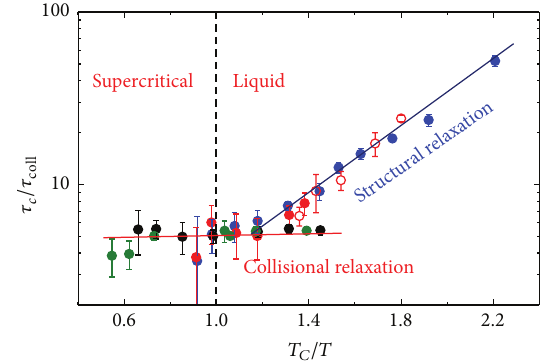
Figure 19: The same data as in Figure 18 are here rescaled for the corresponding collisional relaxation time (see (11)). The straight lines through the data serve as guide to eye. The vertical dashed line indicates the critical